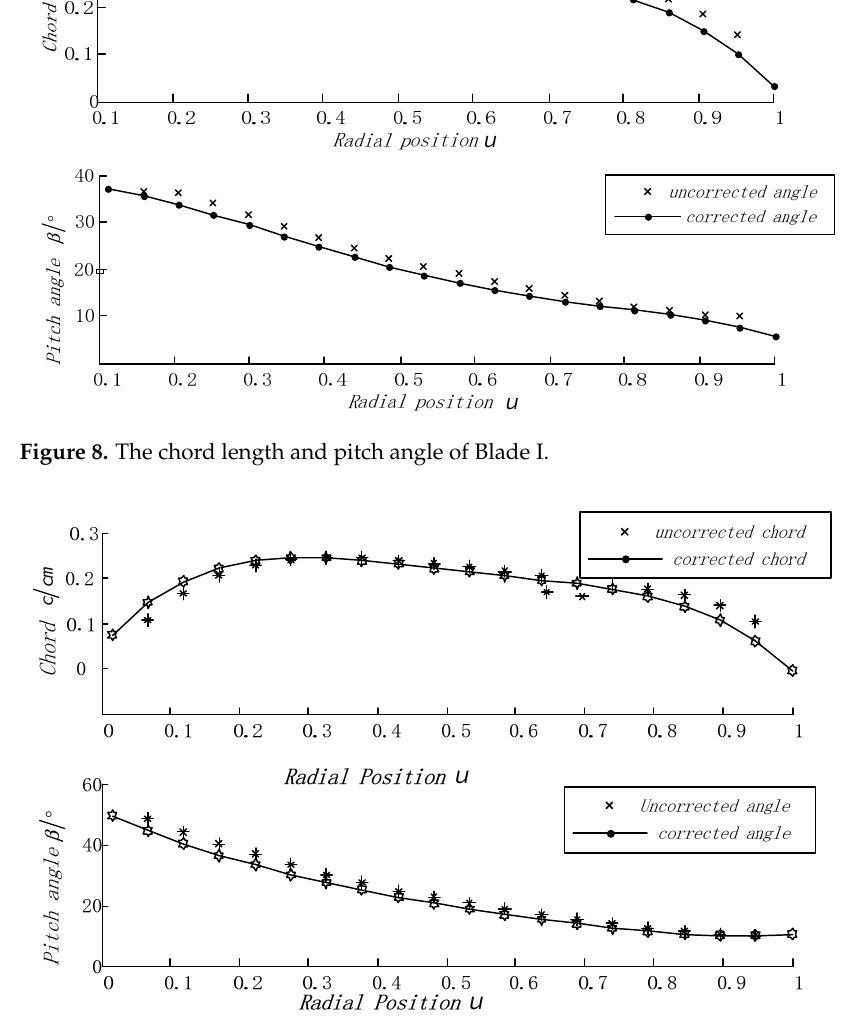
Figure 9. The chord length and a pitch angle of the Blade Ⅱ .